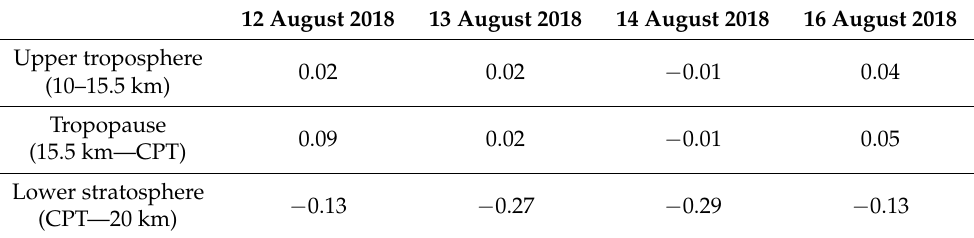
C 2 n (m 7/3 ) within upper troposphere, tropopause, and lower Table 3. Increase rate of log 10 Table 3. Increase rate of log (cid:2869)(cid:2868) 𝐶 (cid:3041)(cid:2870) ( m (cid:2875) (cid:2871)⁄ ) within upper troposphere, tropopause, and lower strato- sphere.